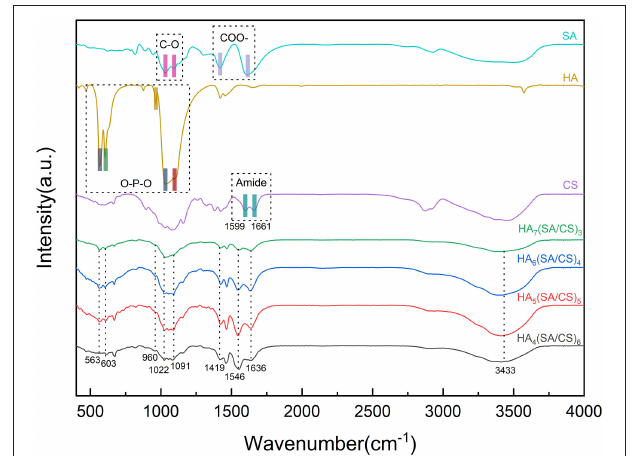
FIGURE 1 | FTIR spectrum of HA, SA, CS, HA 7 (SA/CS) 3 scaffold, HA 6 (SA/CS) 4 scaffold, HA 5 (SA/CS) 5 scaffold, and HA 4 (SA/CS) 6